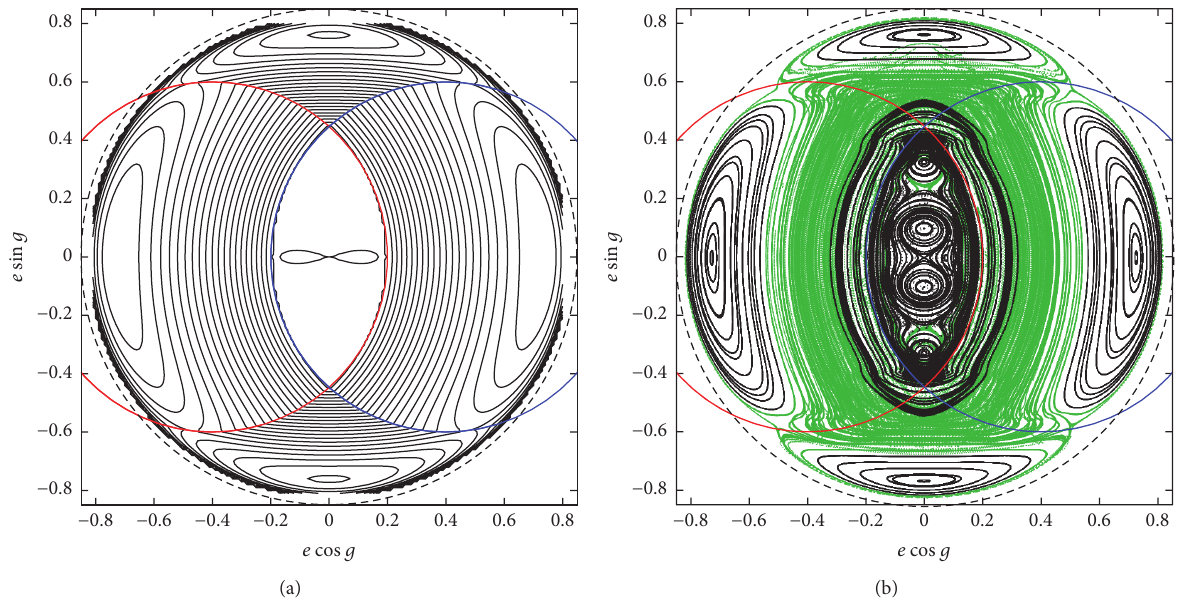
Figure 4: (a) Extended plot of Figure 2(f) up to 𝑒 = 𝑒 max (numerical quadrature). (b) Extended plot of Figure 3(f) (numerical integration). Note that we set the contour interval in (a) ten times larger than in Figure 2(f) for a better visibility of plots. The interval of initial eccentricity in (b) is twice larger than in Figure 3(f) for the same